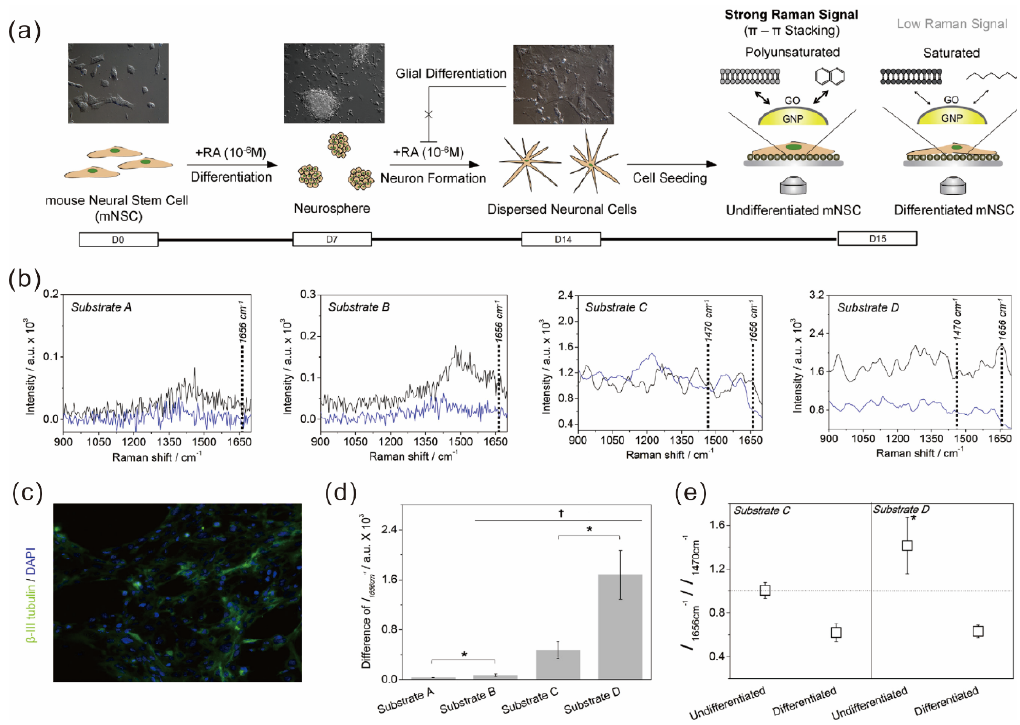
Figure 7. ( a ) Schematic diagram depicting the method to distinguish the undifferentiated and differentiated state of mouse neural stem cells (mNSCs) using 3D GO-encapsulated gold nanoparticles; ( b ) Raman signals achieved from undifferentiated (black) or differentiated (blue) mNSCs on different substrates including indium tin oxide (ITO, Substrate A), GO-modified ITO (Substrate B), gold nanoparticle-modified ITO (Substrate C), and ITO modified with GO-encapsulated gold nanoparticles (Substrate D); ( c ) Fluorescence images of differentiated mNSCs on Substrate D proving the successful differentiation of mNSCs to neurons; ( d ) Intensities of Raman peak (1656 cm ´ 1 ) obtained from undifferentiated mNSCs subtracted by differentiated cells; ( e ) Relative Raman intensities at 1656 cm ´ 1 divided by the intensities at 1470 cm ´ 1 . * p < 0.05, Student’s t-test. Reprinted from [50], Copyright 2013, with permission from Elsevier.